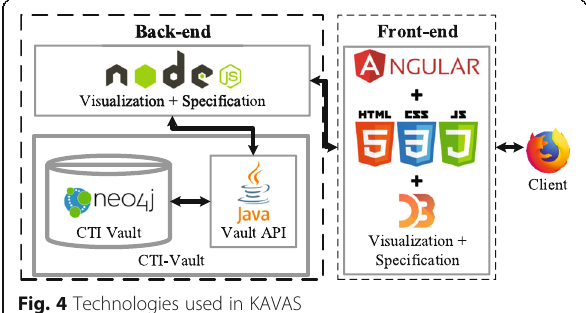
Fig. 4 Technologies used in